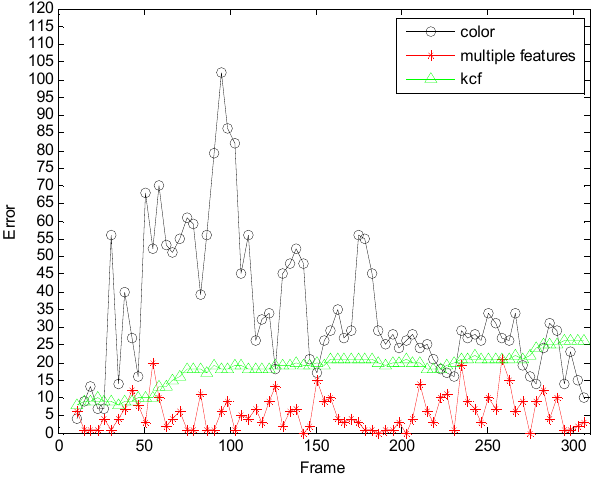
Figure 19. The RMSE comparison corresponding with KCF.